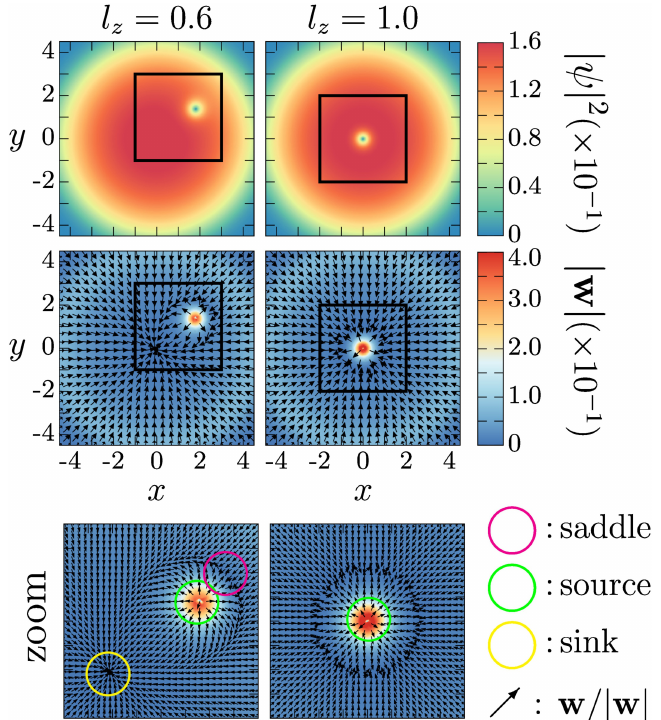
Figure 4 . The panels show the minimal energy configurations for values of the angular momentum l z = 0 . 6 and 1 and N = 1 for the dimensionless coupling g = 400 . The panels on the top row display the density | ψ | 2 . The middle panels display the corresponding vector field w ( x ) , and the bottom line shows the corresponding data zoomed closer to the fixed points of w ( x ) . The green and yellow circles respectively highlight the source (the vortex) and sink of w ( x ) . The saddle of w ( x ) is represented by magenta circle. All these circles correspond to different trajectories Γ in eq. (2.4), for the vector field w ( x )